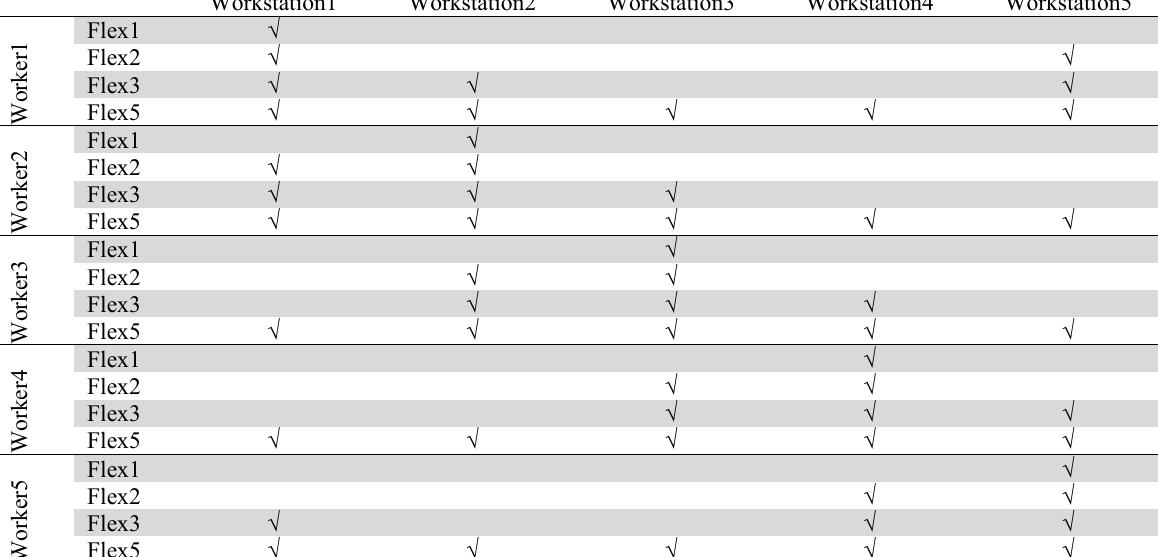
Worker’s transfers configurations according to Flex1, Flex2, Flex3 and Flex5 Workstation1 Workstation2 Workstation3 Workstation4 Workstation5